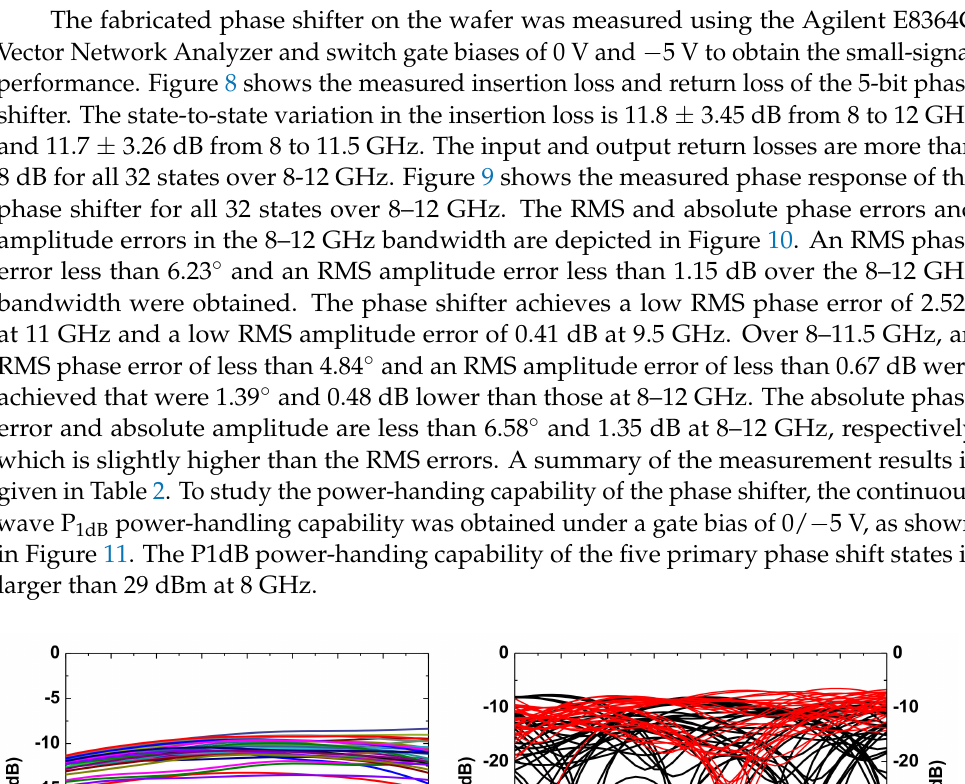
Figure 7. Photograph of the 5-bit gallium nitride (GaN) monolithic microwave integrated circuit (MMIC) phase shifter.